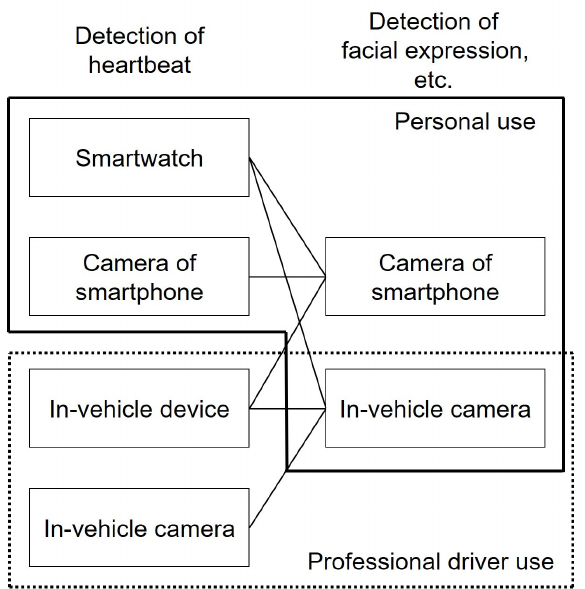
Figure 7. Segregation of the device for detection of heartbeat and expression. The lines connected from each block of “Detection of heartbeat” to each block of “Detection of facial expression, etc.” show the possible combination for adapting in-vehicle